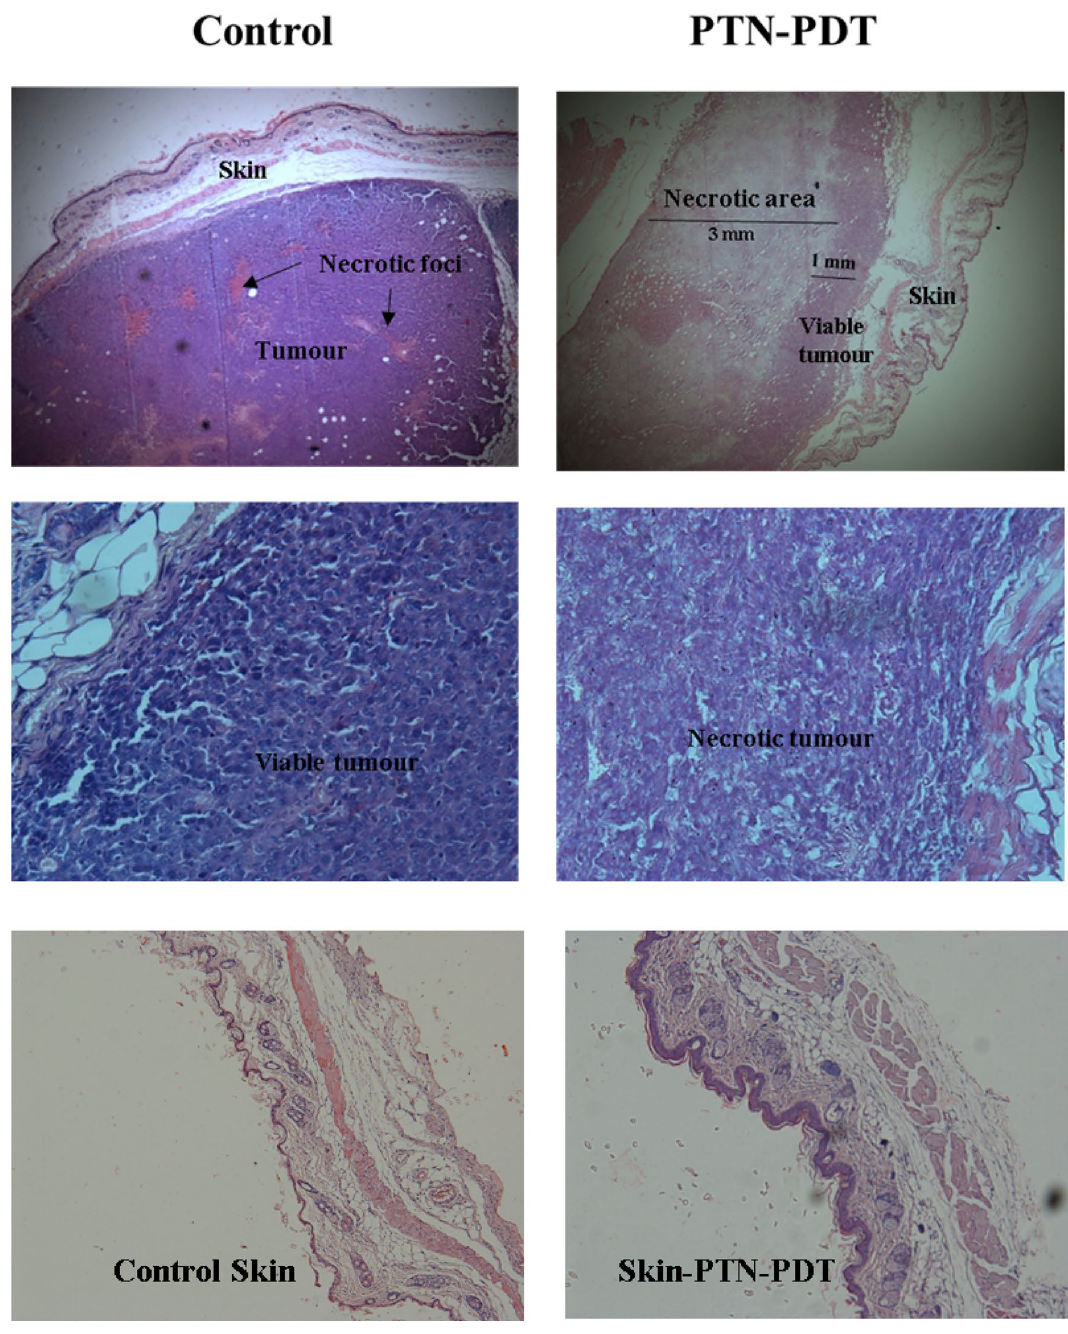
Figure 8. Hematoxylin and eosin-stained images of skin and adjacent tumours and normal skins treated with topical PTN-PDT. PTN-PDT treated tumours were excised 24 h after the second PDT dose (day 4 of the experiment). Controls of tumours treated with vehicle were included. Sections were photographed using the × 4 (upper panel) and × 40 (middle panel) objectives. Lower panel represents normal skins excised 24 h after the second PDT dose and non-treated controls (×